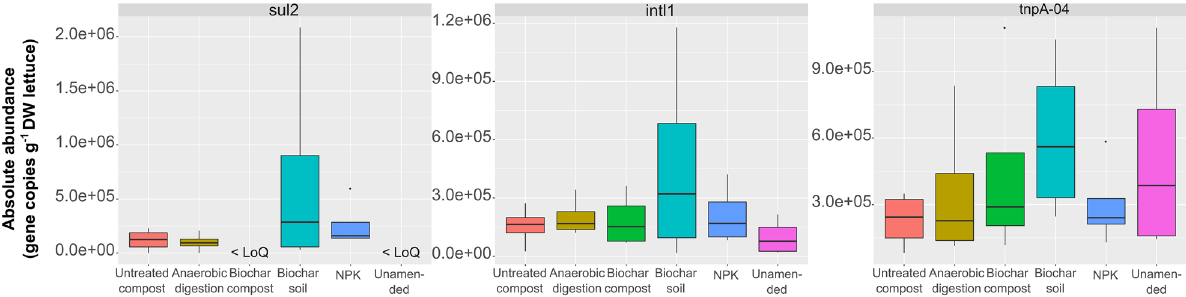
Figure 3. Absolute abundances of antibiotic resistance genes (ARGs) and mobile genetic element (MGE) genes in the lettuce samples according to the ddPCR analysis, expressed as gene copies per g of DW lettuce (n = 4). No statistically significant differences were found among the treatments. LoQ: limit of quantification.